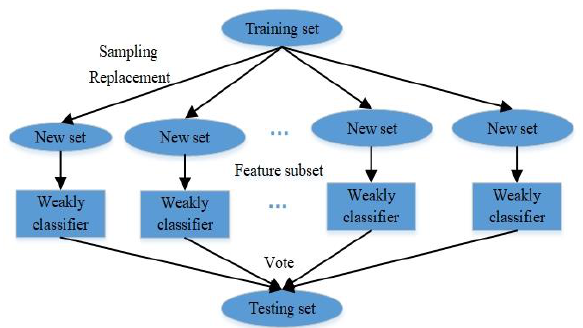
Figure 2. Schematic diagram of RF